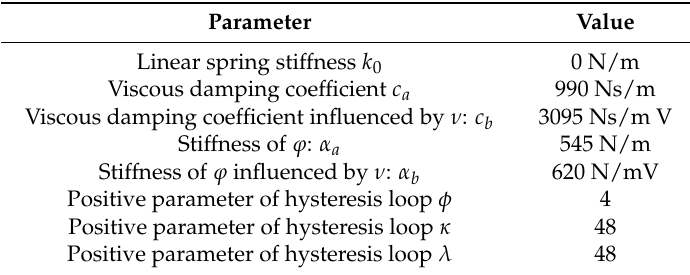
Table 3. Parameters to calculate the applied current of MR damper.